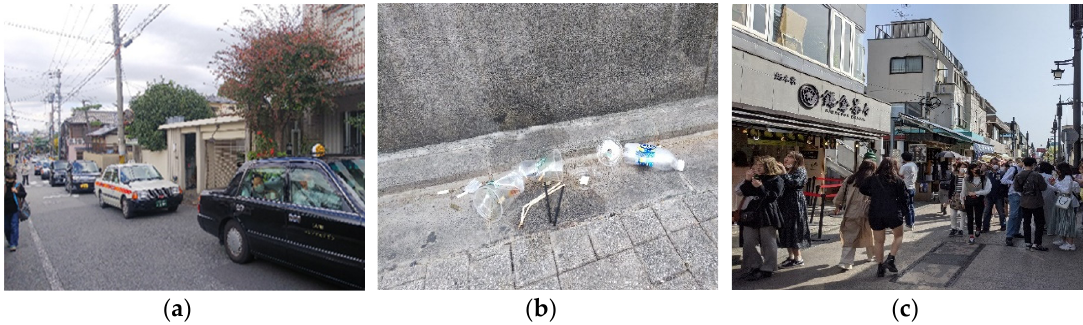
Figure 2. Examples of visitors’ actions (Source: Authors) ( a ) Kyoto—22 November 2020, ( b ) Kyoto—3 October 2020, ( c ) Kamakura—31 March 2021 .